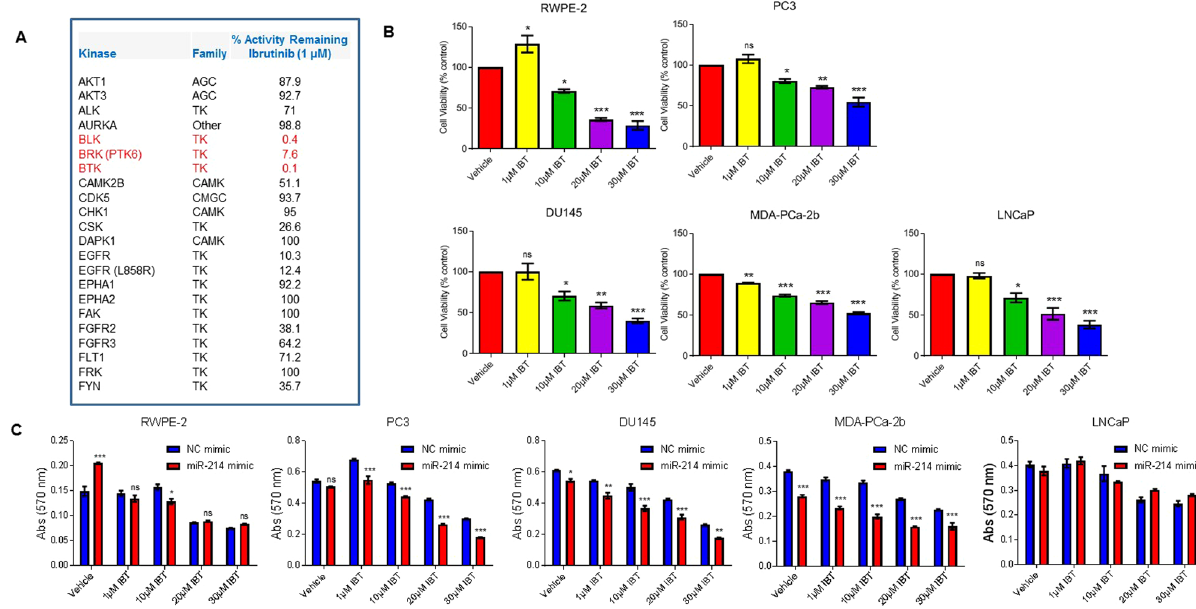
Figure 6. Effects of ibrutinib on prostate cancer cell proliferation. ( A ) Ibrutinib inactivates PTK6 activity in vitro (as indicated in red). ( B ) RWPE-2, PC3, DU145, MDA-PCa-2b, and LNCaP cells were treated with increasing concentrations of ibrutinib for 48 h, and then cell proliferation was measured by MTT